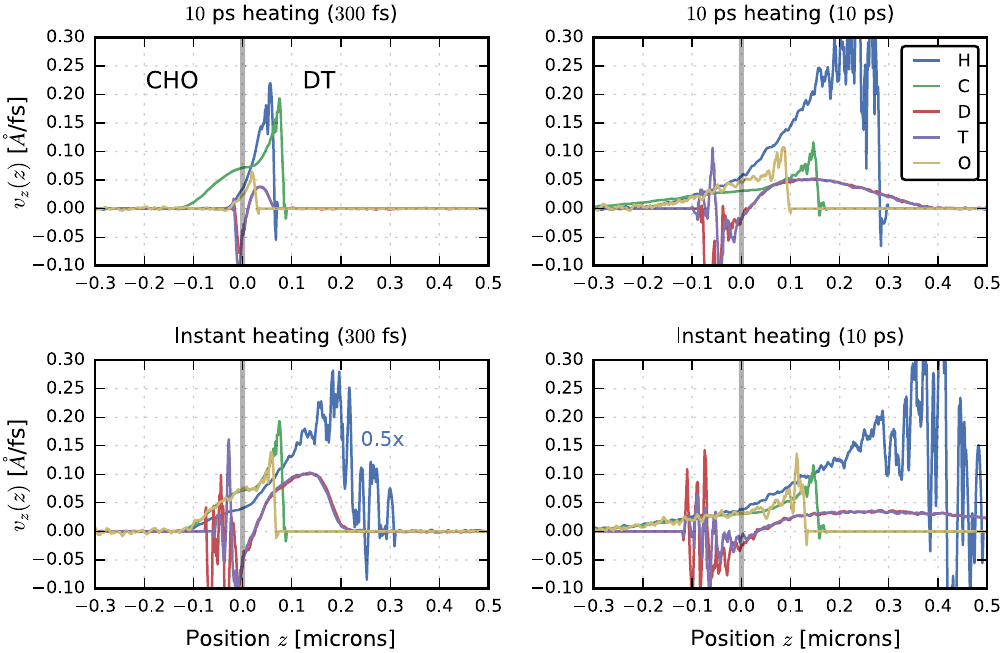
FIG. 9. Velocity fields. The z component of the velocity field of each species is shown. Hydrogen jetting is reflected in the large values z Þ for that species, relative to the others; the jetting is obviously more extreme with instantaneous heating. (In the lower-left panel, of v z ð the H velocity field has been scaled by a factor of